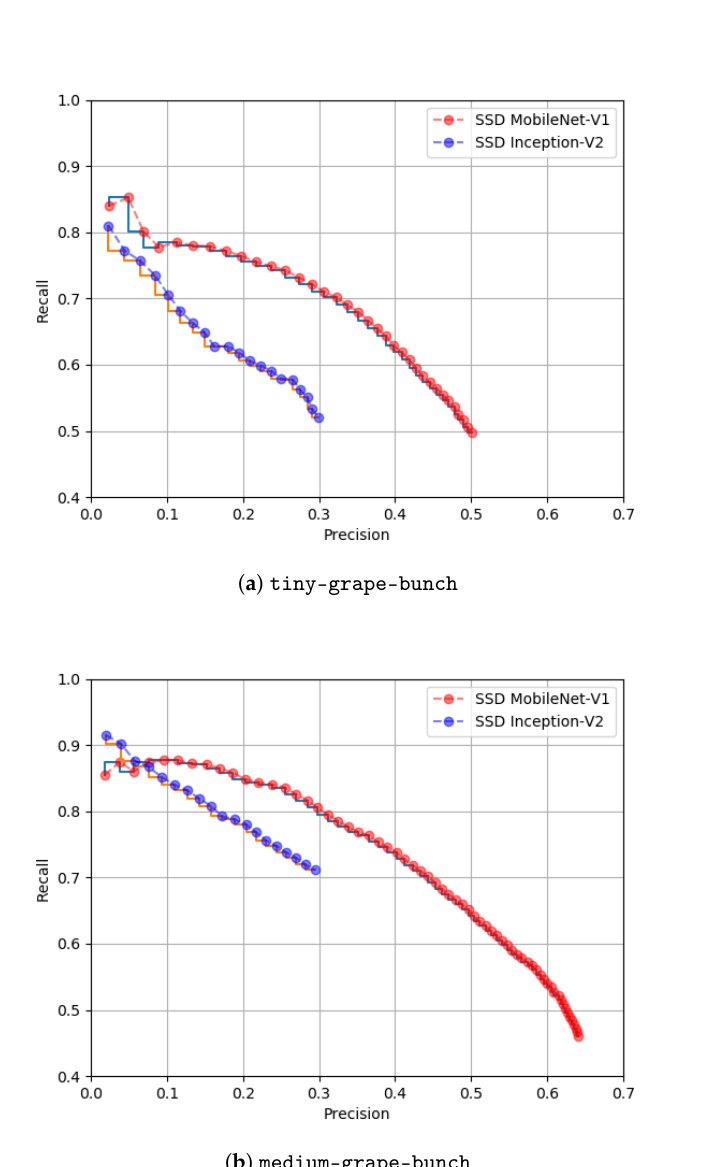
Figure 8. Precision × recall curves for both models and both classes considering a confidence score of 50% and an IoU of